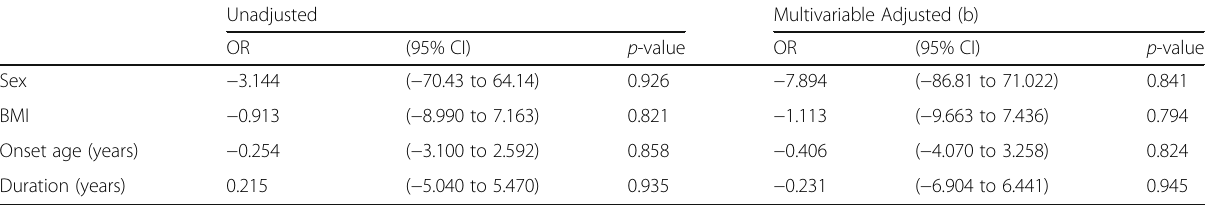
Table 3 Association between patient features and RBD symptom frequencies